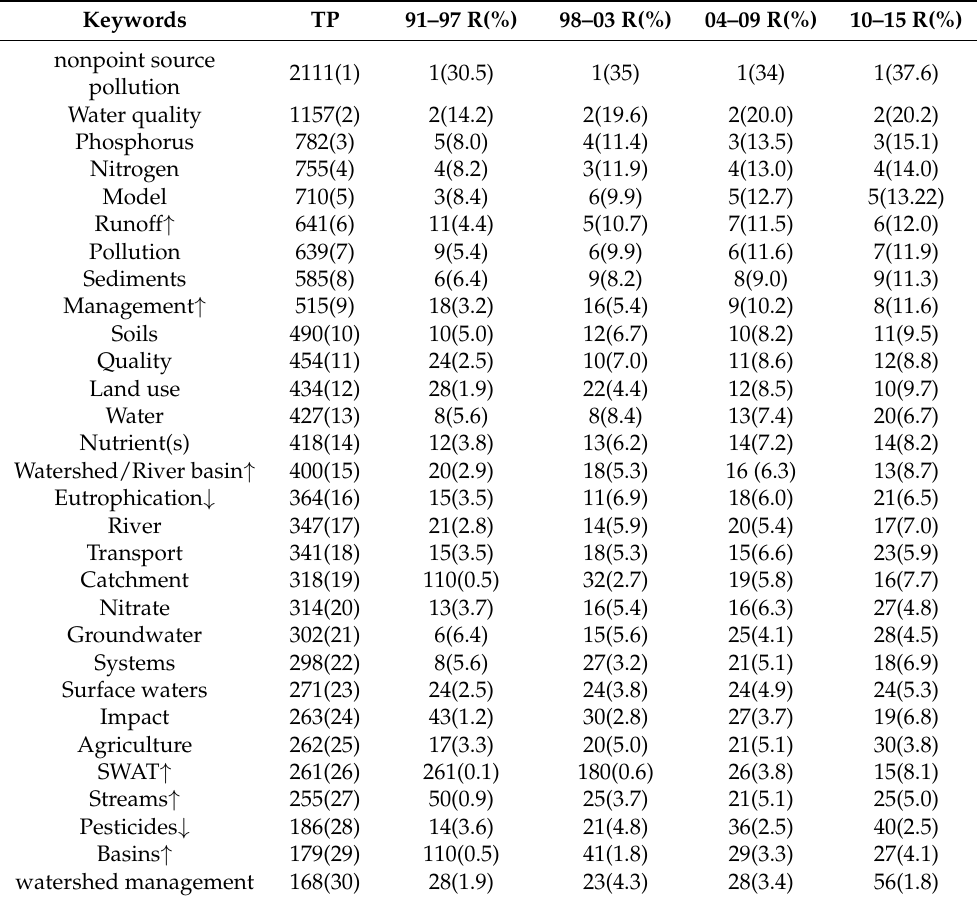
Table 5. Thirty most frequent keywords in NPS